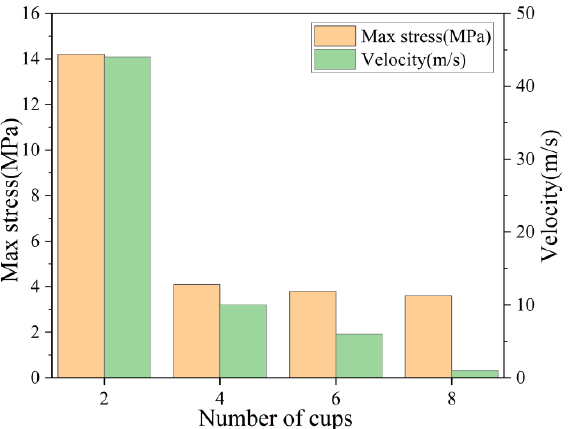
Figure 8. Maximum stress versus speed for different cup pipe robots during bending.